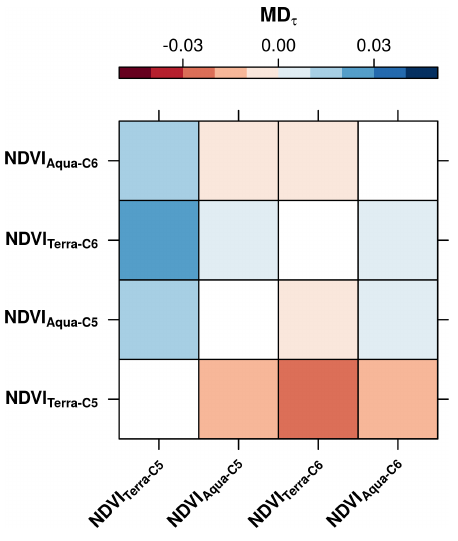
Figure 3. MD τ calculated from “significant” values of τ ( p < 0.05) for each pair of MODIS NDVI